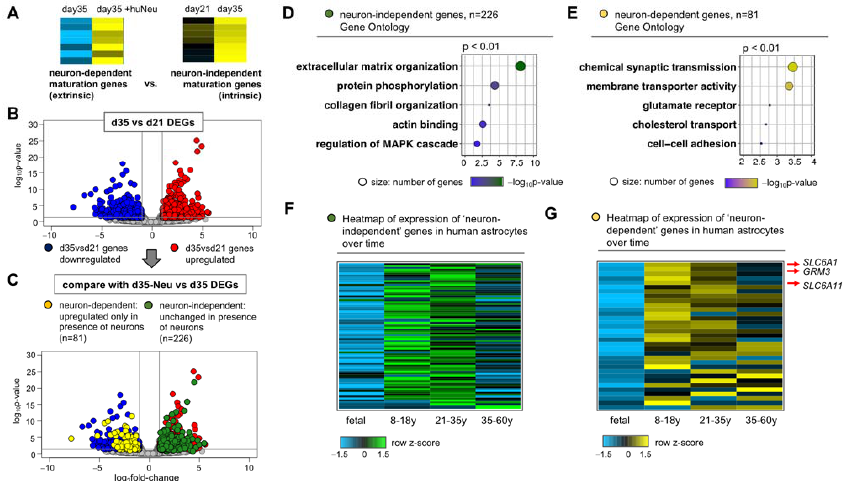
Figure 3. A mixed-species co-culture system enables the identification of neuron-independent and neuron-dependent pro- grams of astrocyte development. ( A ) Schematic of the bioinformatic approach to identify gene sets. ( B ) Volcano plot show- ing significance versus log 2 fold-change depicting RNA-Seq data comparing day 35 and day 21 mES_astrocyte transcrip- tomes ( n = 3, p < 0.05, fold-change > 2). ( C ) Comparison of DEGs shown in ( B ) with genes differentially expressed in co- cultures to identify neuron-independent and neuron-dependent genes, shown by green and yellow circles, respectively. ( D , E ) GO terms of top genes from both sets ( p < 0.01). Heatmap showing expression levels of ( F ) neuron-independent and ( G ) neuron-dependent gene sets in human astrocytes at different ages, from fetal to 60 years. Detailed gene lists used for heatmap generation are given in Table S1. Next, we asked whether the neuronal-associated maturation signatures identified above are present in human astrocytes. Using transcriptomic data from human astrocytes at different ages, from fetal to 60 years of age [36], we identified a subset of ~50 neuron- independent genes that are enriched at least twofold in both age groups of 8–18 years and 21–35 years over fetal astrocytes (Figure 3F). Within the two age groups, 8–18 years and 21–35 years, only 8 genes were enriched in the 21–35-year age group, indicating that once astrocytic neuron-independent maturation genes are established, their expression levels are maintained at consistent levels till 18–35 years of age. Interestingly, a majority of these